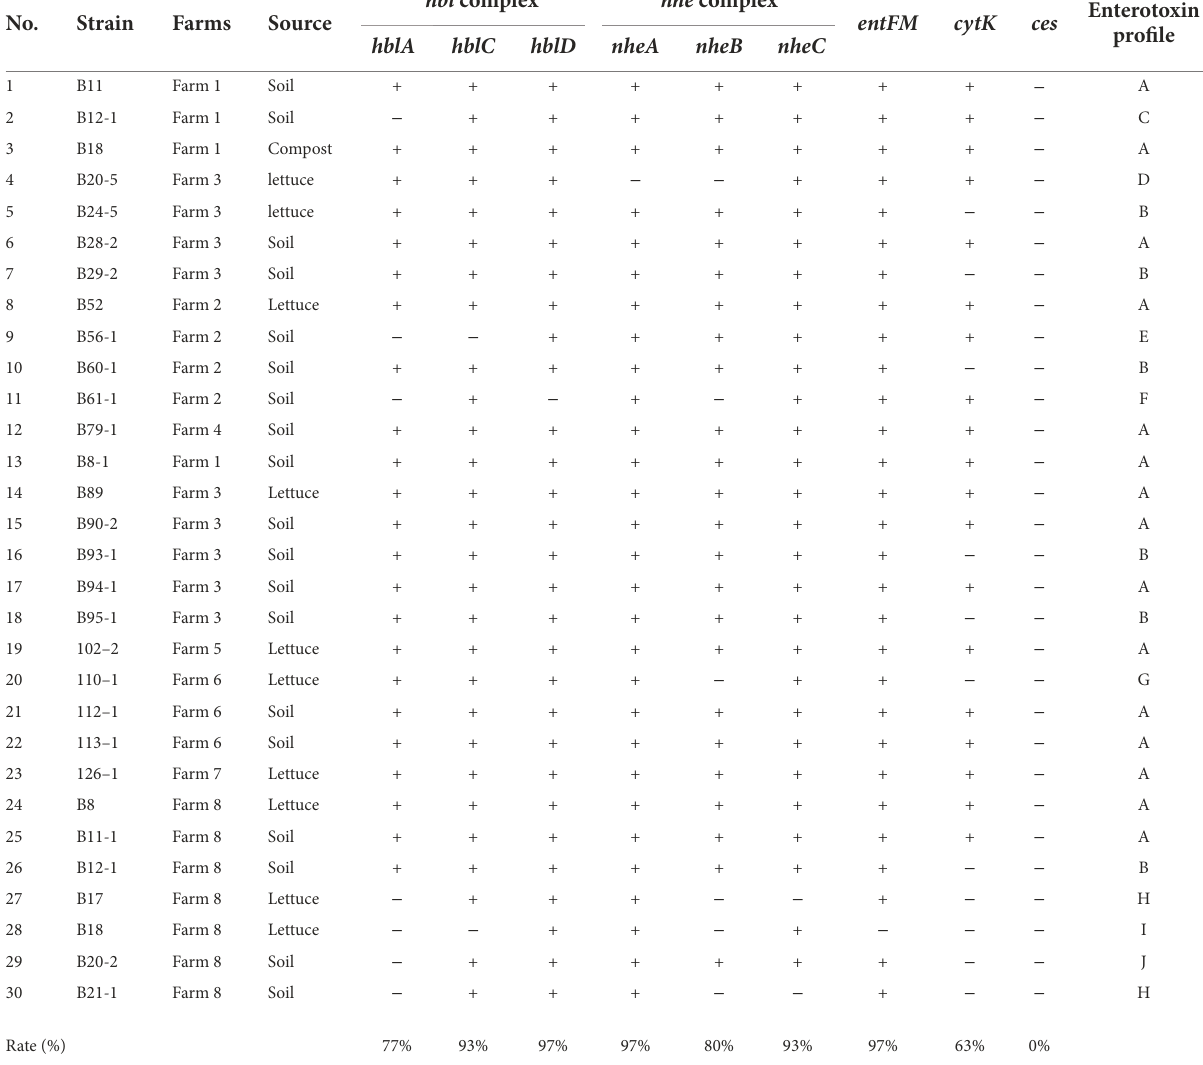
TABLE 4 Distribution of toxin genes among Bacillus cereus strains isolated from lettuce farms. hbl complex nhe No. Strain Farms Source